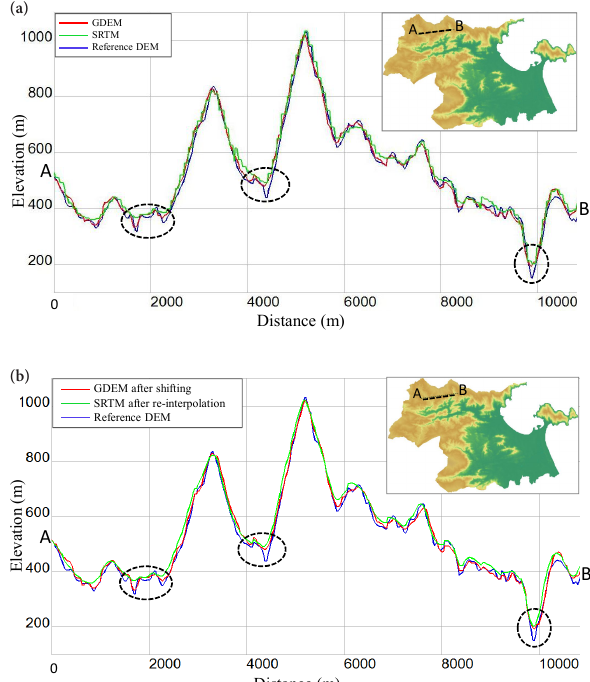
Figure 5. Comparing GDEM and SRTM to the reference DEM: (a) before re-interpolation SRTM and shifting data, (b) after re- interpolation SRTM and shifting